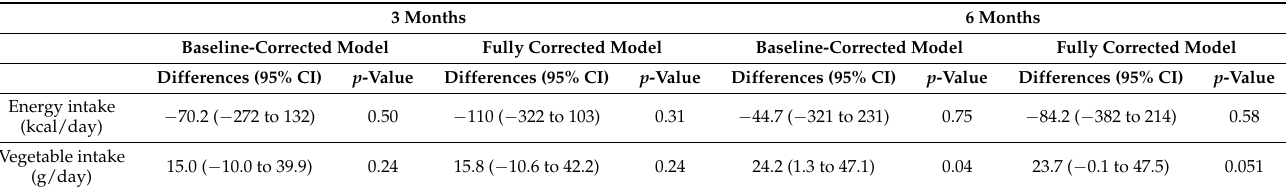
Figure 2. Estimated marginal means of energy intake, steps and total MVPA, QoL, and BMI at baseline, 3 months, and 6 months. ( A ) Energy intake; ( B ) Steps; ( C ) Total MVPA; ( D ) BMI; ( E ) Physical Component Score; ( F ) Mental Component Score. MVPA: moderate to vigorous physical activity. Data were corrected for age, baseline measures, education, smoking at baseline, time, PCOS group, and interaction between time and PCOS group. * p < 0.05 between women with PCOS and non-PCOS controls at three months. Table 2. Differences in dietary intake, physical activity, and QoL in the PCOS group compared with non-PCOS group.